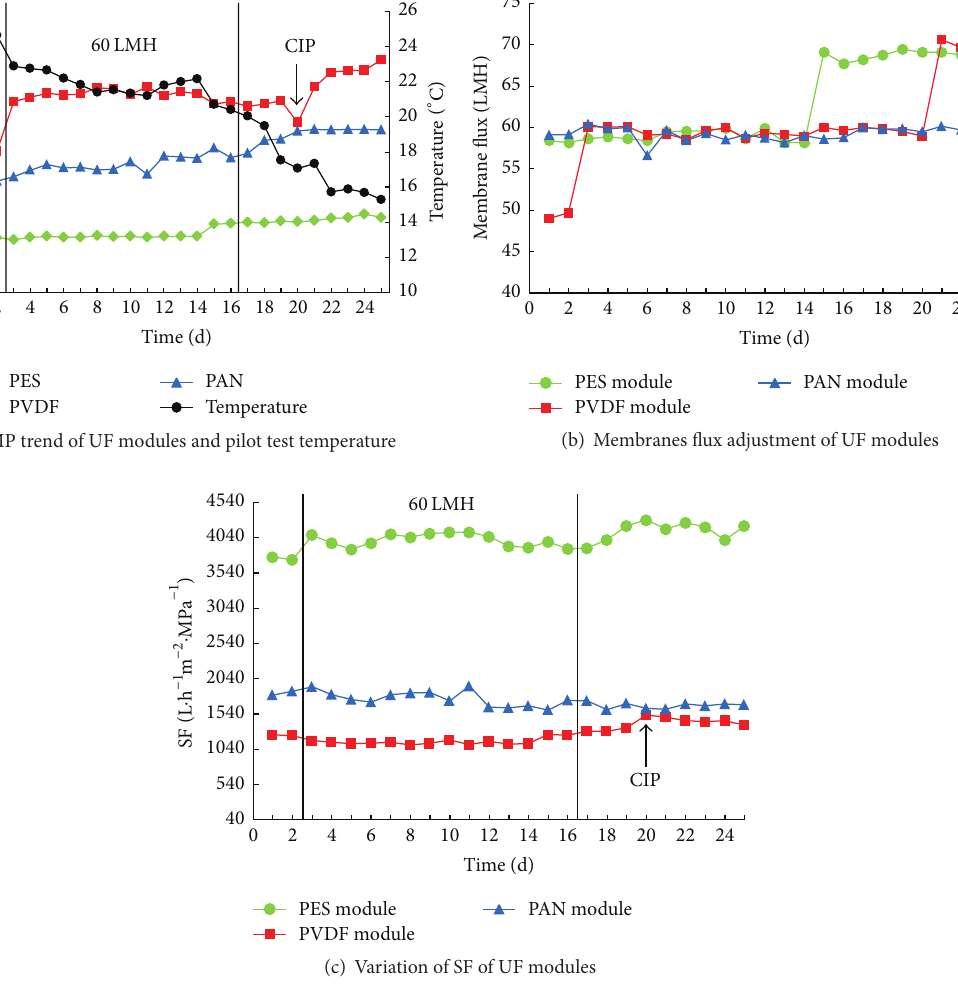
Figure 5: Tendency of basic parameters of UF modules during